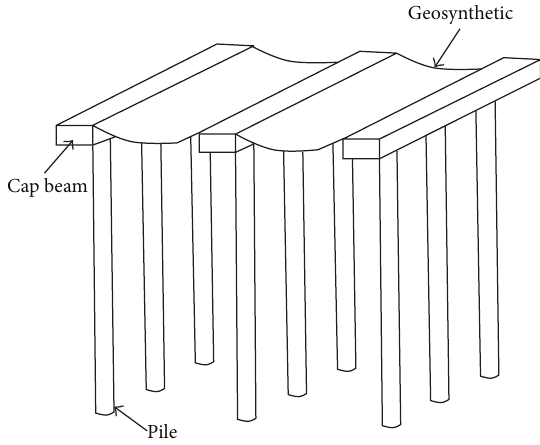
Figure 1: Embankment piles with cap beams and geosynthetic reinforcement.